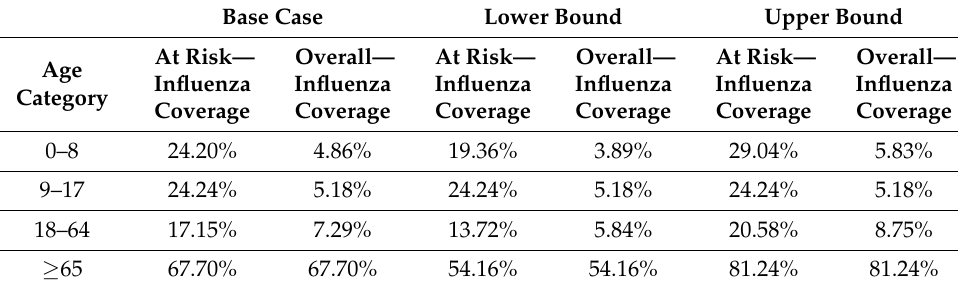
Table A4. Lower and upper bounds for vaccine coverage in